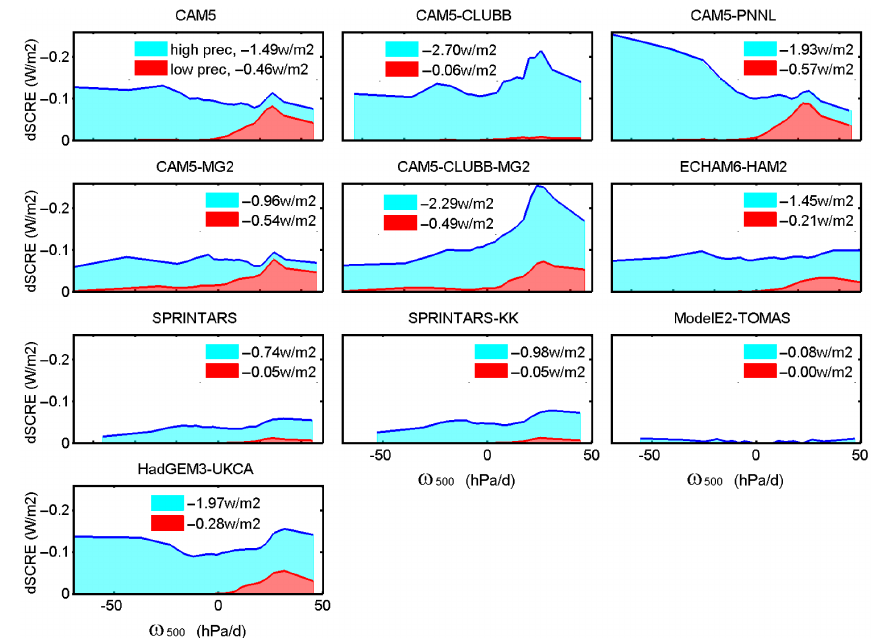
Figure 7. Change in shortwave cloud radiative effect (dSCRE, shown in blue line) from PI to PD as a function of dynamic regimes. Red patches are dSCRE contributed by low precipitation situations while blue patches are by high precipitation